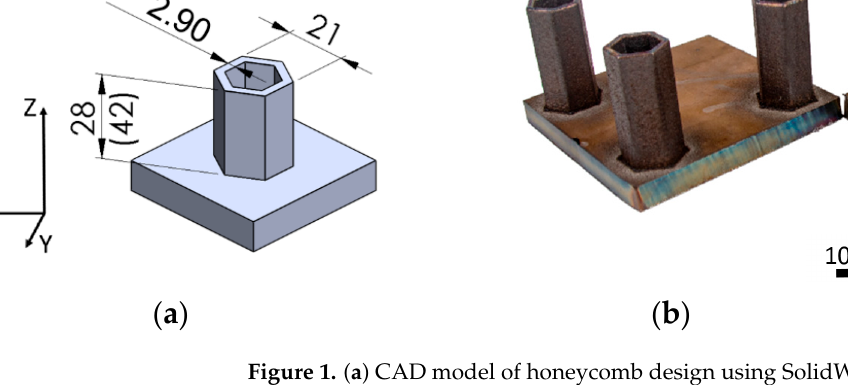
Figure 1. ( a ) CAD model of honeycomb design using SolidWorks (SHORT—height of 28 mm) with the dimensions of the build captured, ( b ) DED-processed sample—LONG (height of 42 mm) and ( c ) SHORT (height of 28 mm).